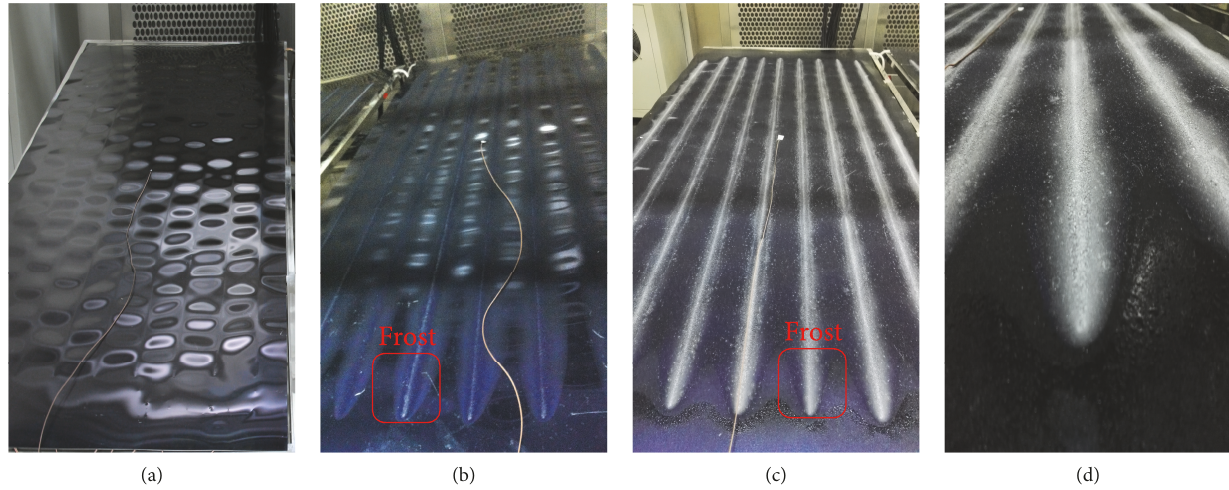
Figure 8: Photo of the surface of the collectors after 120min of operating (a) RH=50%; (b) RH =70%; (c) RH =90%; (d) details of the frost when RH =90%.